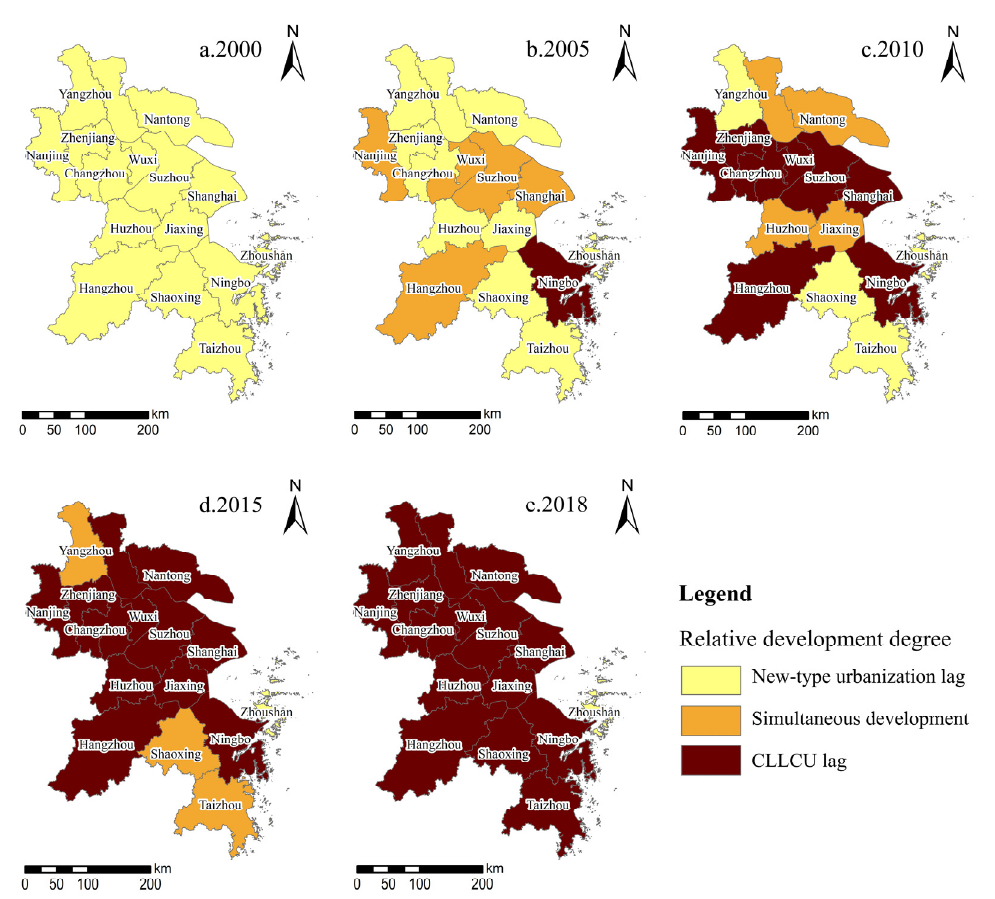
Figure 11. The spatial pattern of relative development between new-type urbanization and cultivated land low-carbon utilization of the Yangtze River Delta during